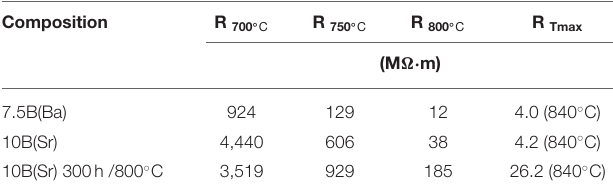
TABLE 3 | Electrical resistance at high temperature of the